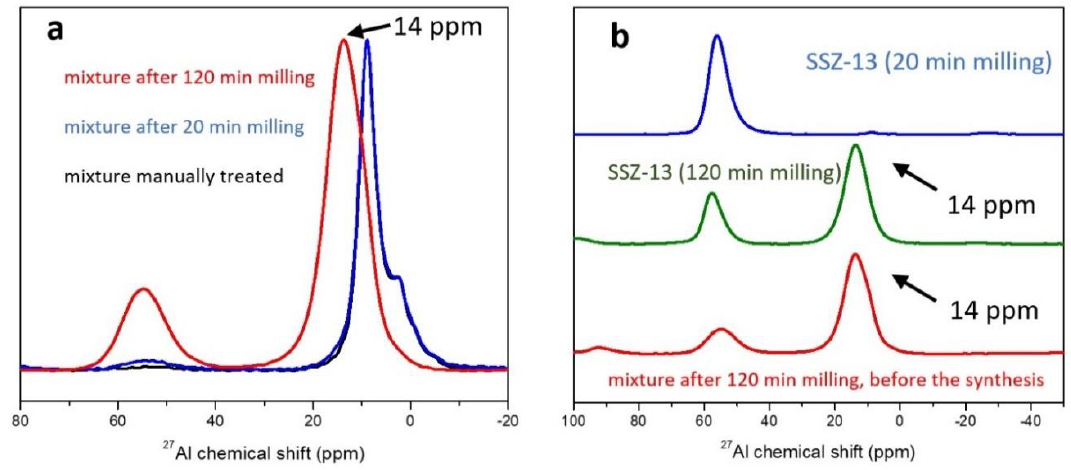
Figure 5. ( a ) 27 Al MAS NMR spectra of the treated mixtures: manually milled for 20 and 120 min; ( b ) comparison of 27 Al MAS NMR spectra of SSZ-13 zeolite products obtained from mixtures milled for 20 and 120 min with the mixture milled for 120 min before the synthesis.